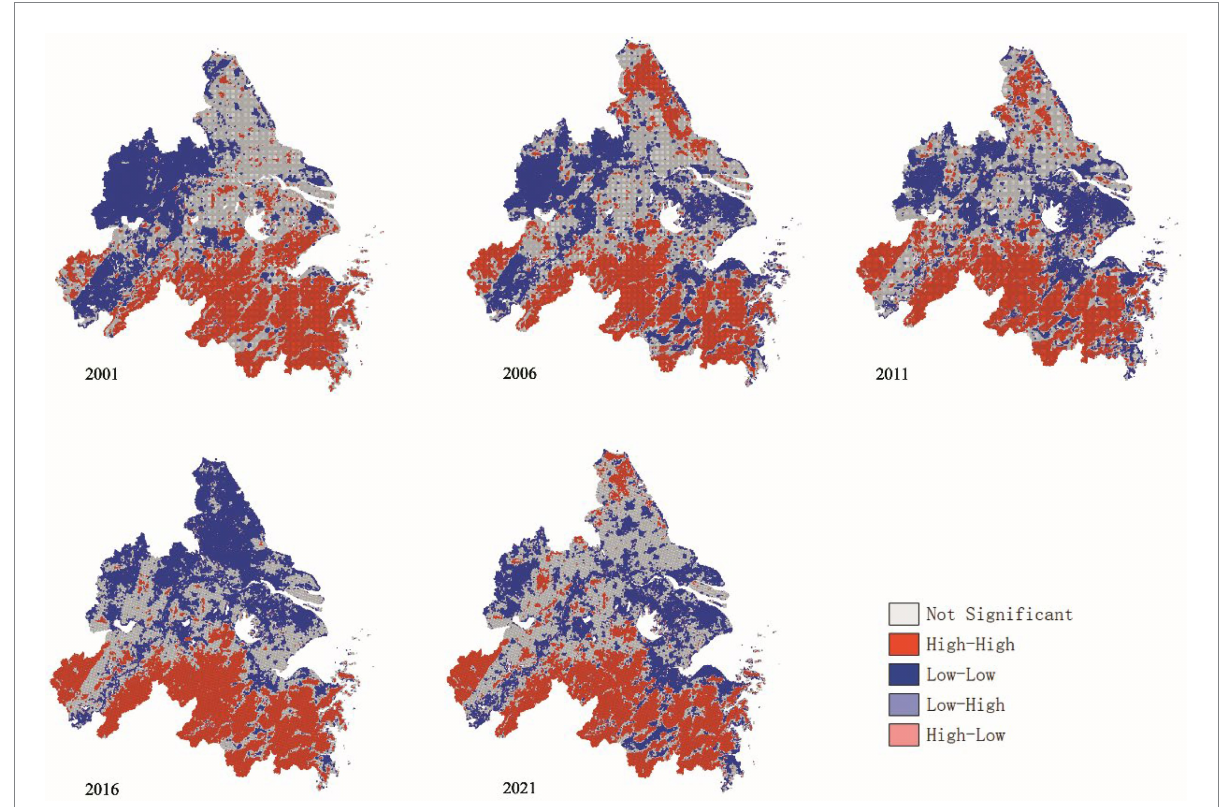
FIGURE 9 LISA cluster map of the MRSEI in Yangtze River Delta Urban Agglomeration from 2001 to